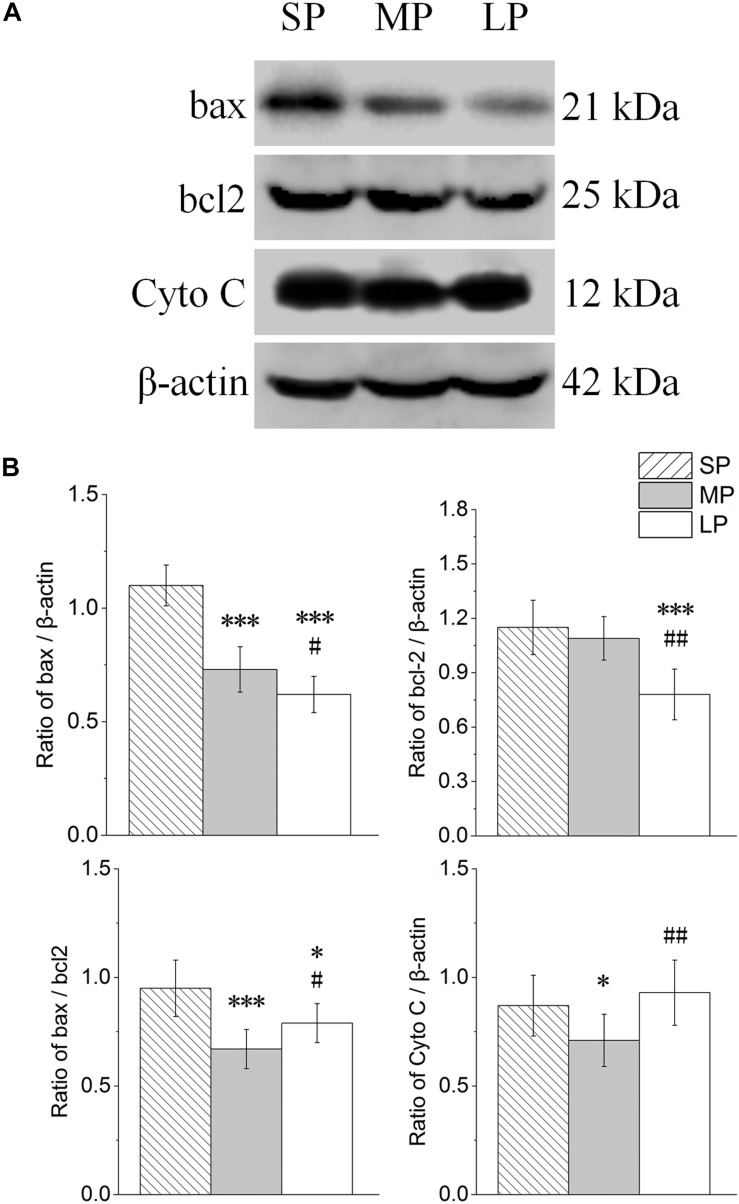
Changes in protein levels of bax, bcl2, Cyto C, and bax/bcl2 in HG of hamsters in three different photoperiodic groups. (A) Representative immunoblots of bax, bcl2, Cyto C, and β-actin in three different photoperiodic groups. (B) Ratio of bax, bcl2, Cyto C to β-actin and ratio of bax to bcl2 in HG of hamsters in three different photoperiodic groups. Values are means ± SD. n = 10. SP, short photoperiod; MP, moderate photoperiod; LP, long photoperiod. ∗P < 0.05, ∗∗∗P < 0.001 compared with SP; #P < 0.05, ##P < 0.01 compared with MP.